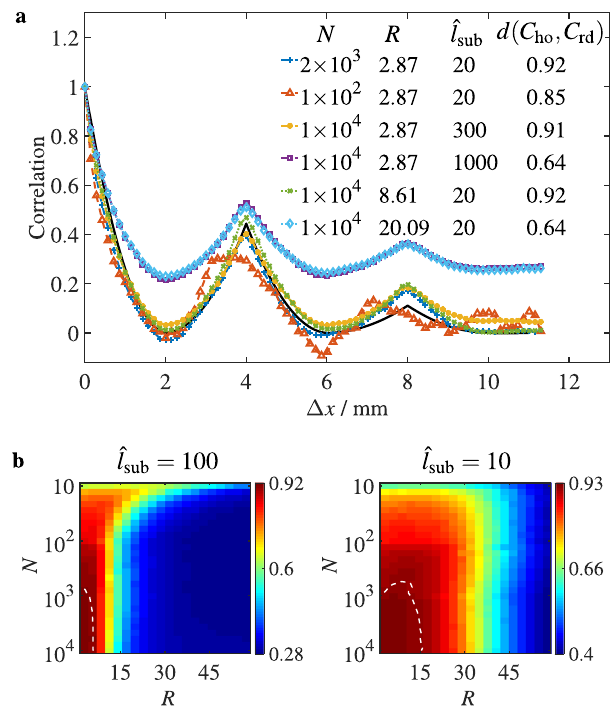
Fig. 2 In fl uence of imaging system parameters on RSESIC method.